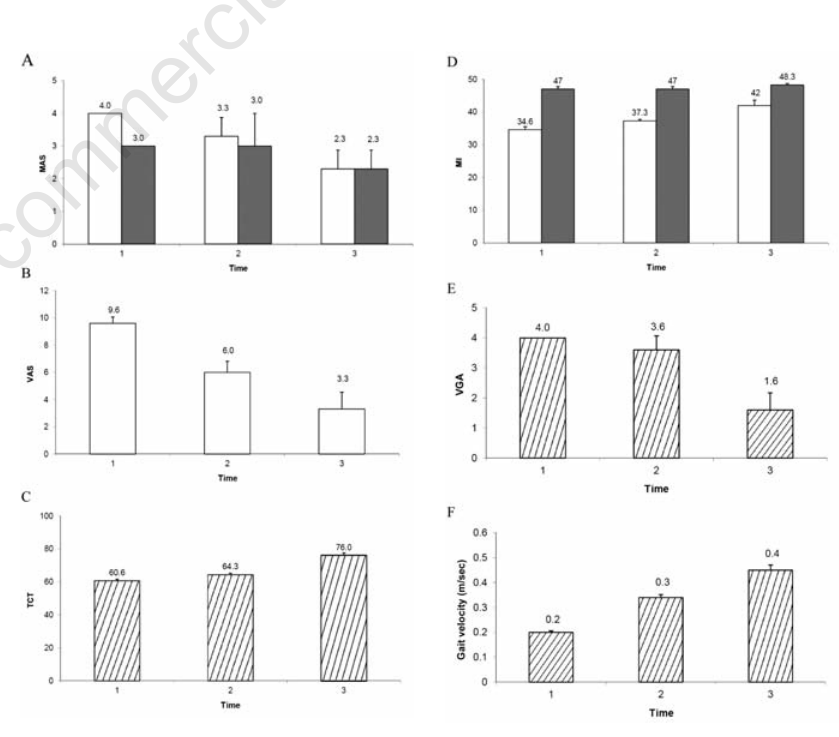
Figure 1. Clinical and functional measurements before, 1 week, and 1 month after Xeomin® administration. A) Spasticity (Modified Ashworth Scale [MAS]); B) Pain (visual analog scale [VAS]); C) Trunk control capacity (TCT); D) Motricity index (MI); E) Visual gait analysis scores (VGA); F) Gait velocity. Numbers given are mean values, with error bars representing standard deviation of three measurements. Open and closed bars represent upper and lower limbs, respectively; hatched bars are used for tests not performed in